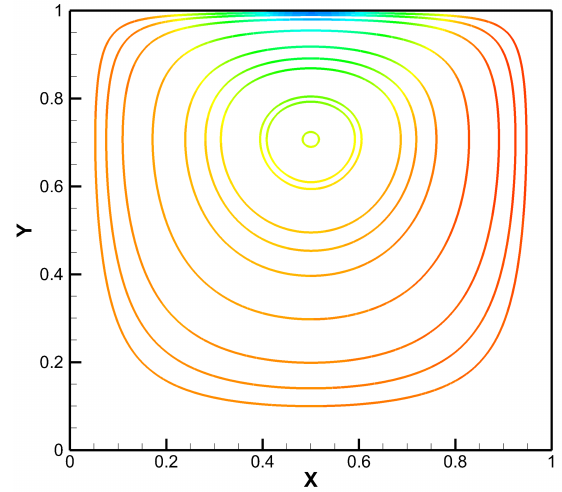
Figure 3. The streamline pattern of the Burggraf flow problem computed by using the U4P4-AP formulation on the 128 × 128